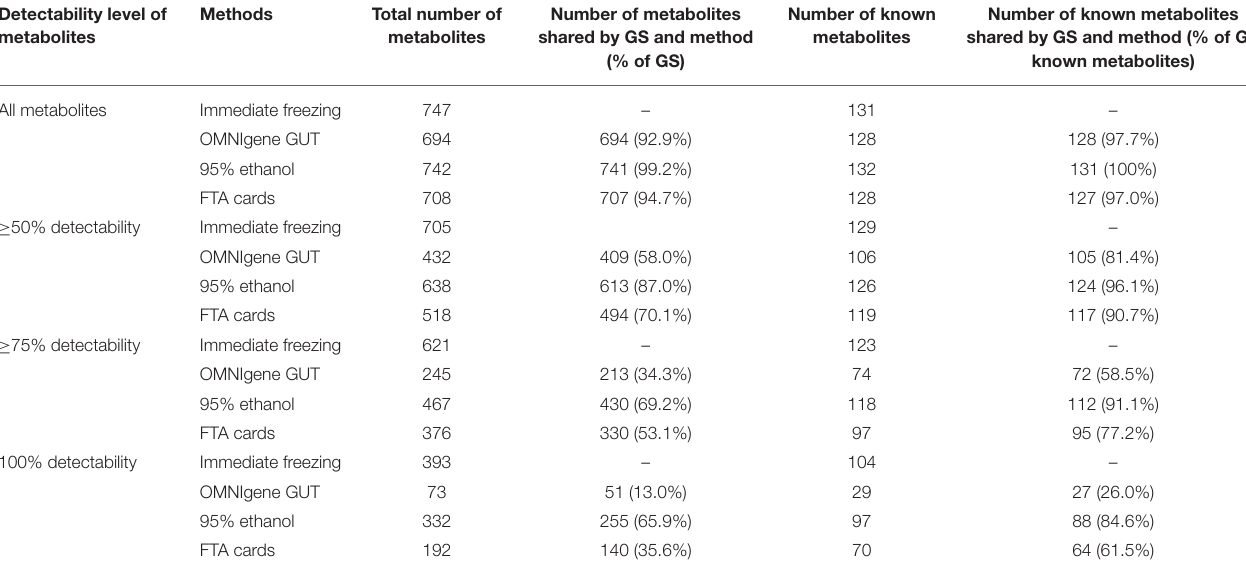
TABLE 1 | Comparison of the number of metabolites at multiple detectability levels across different collection methods. Detectability level of